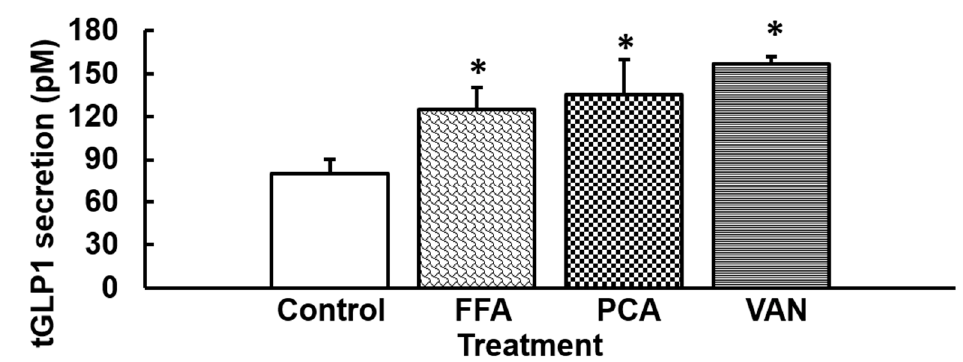
Figure 3. Ex vivo ileum rat total GLP1 secretion induced by hTAS2R14 agonists. Rat segments of ileum were treated with Flufenamic acid(FFA) 50 µ M, protocatechuic acid(PCA) 300 µ M or Vanillic acid(VAN) 300 µ M for 30 min. Afterwards, the medium was collected and total GLP1 was quantified by ELISA ( n = 6–10 segments). Mean ± SEM. * denotes p < 0.05 vs. control.